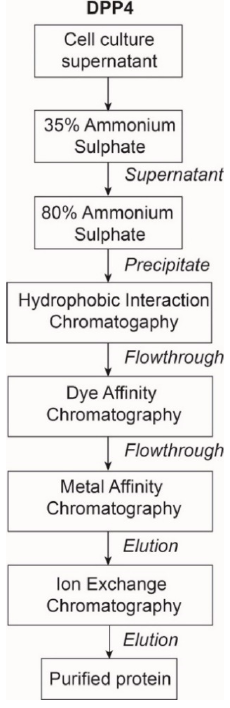
Figure 1. Overview of DPP4 purification workflow.